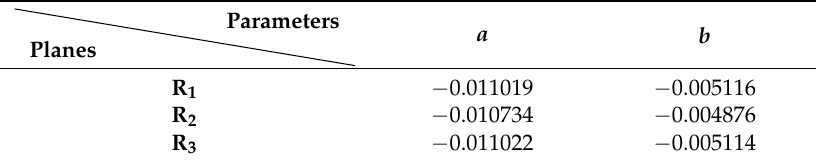
Table 2. Parameters of the equations of the planes.